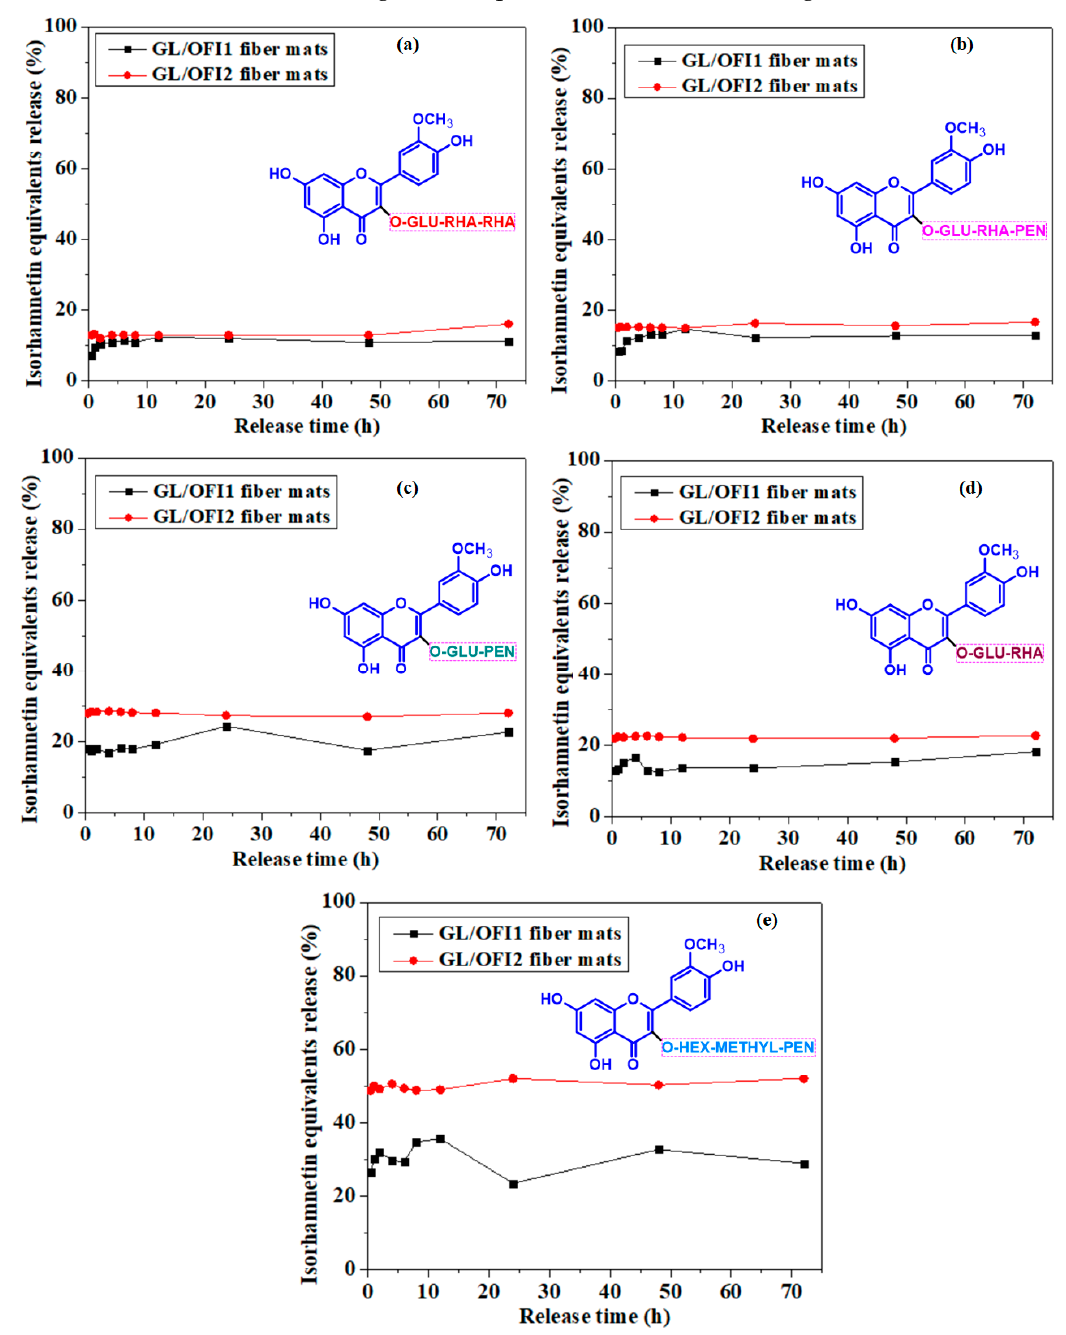
Figure 8. Release kinetics of different isorhamnetin glycosides: ( a ) IGRR, ( b ) IGRP, ( c ) IGP, ( d ) IGR, ( e ) IHMP] from GL/OFI1 or GL/OFI2 nanofibers. GLU : Glucose; RHA : Rhamnose; PEN : Pentose; HEX : Hexose; MP : Methyl